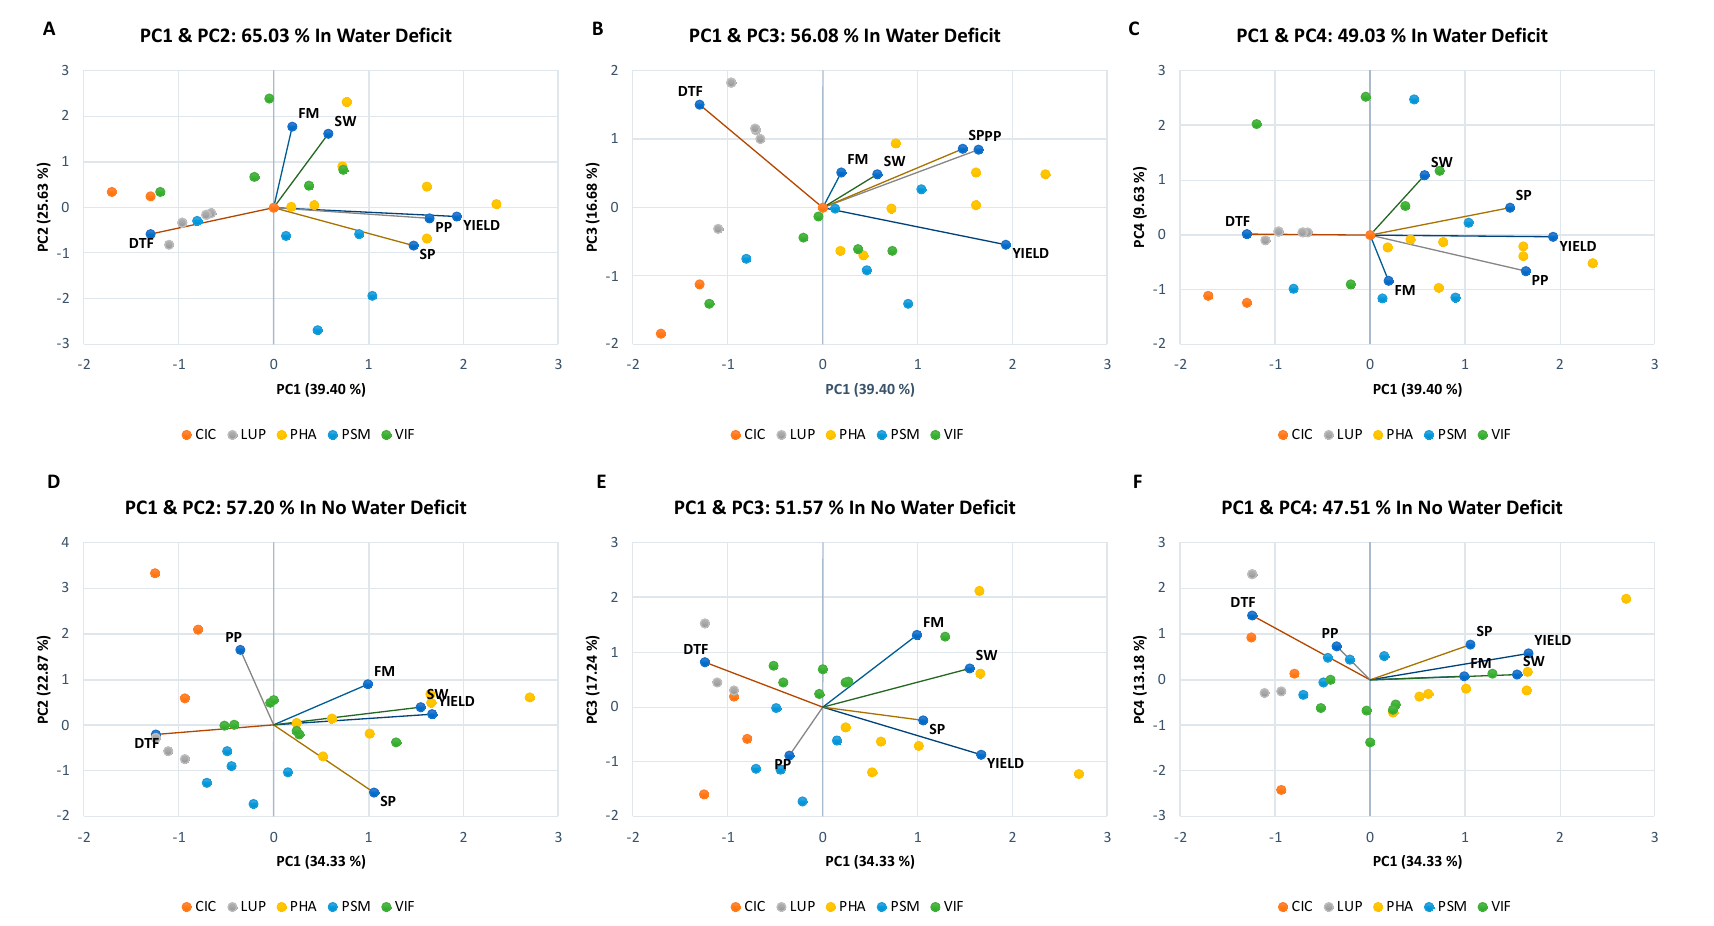
Figure 6. Biplot for the first (PC1), second (PC2), third (PC3) and fourth (PC4) principal component analysis (PCA) scores for the most important physiological traits associated with seed yield (kg ha − 1 ) under ( A – C ) drought conditions (water deficit) and ( D – F ) normal irrigation control conditions (no water deficit). The percentage of variation accounted for by each PC is displayed on the axes. The factor loading values for variables are indicated by arrows radiating from the center showing the direction (angle) and magnitude (length). DTF = days to flowering; FM = chlorophyll fluorometer measurement; SW = seed weight; PP = number of pods per plant; SP = number of seeds per pod.